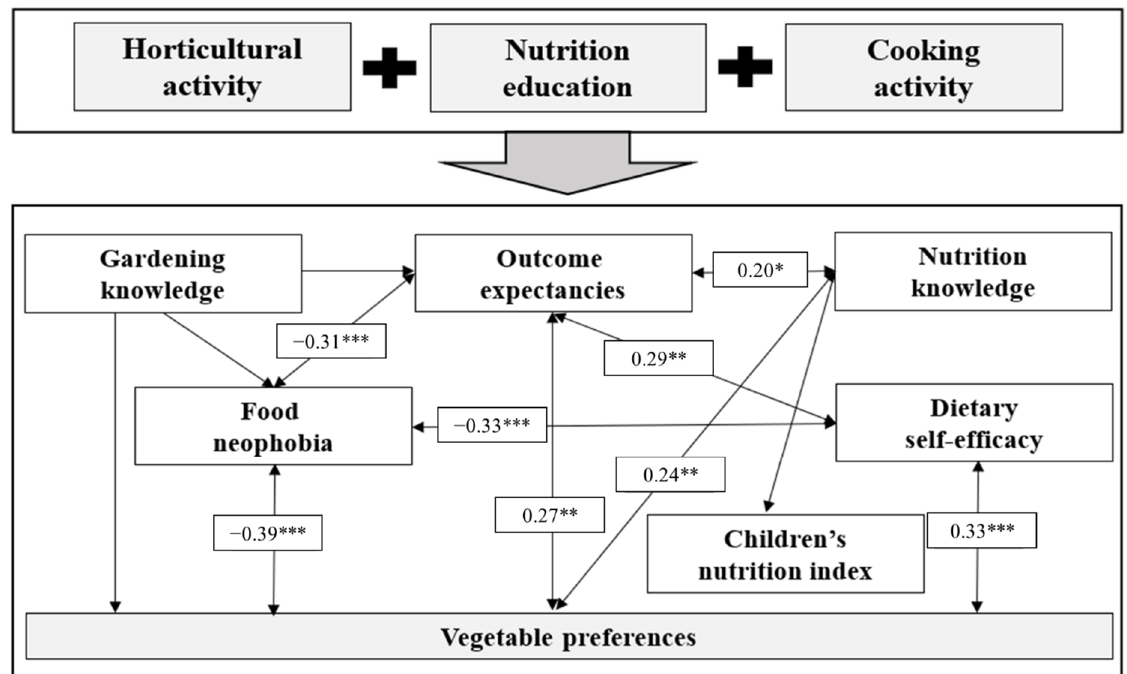
Figure 1. The result of the correlations between mediating factors for improving elementary school children’s vegetable preference ( N = 136). * p < 0.05, ** p < 0.01, *** p < 0.001. A correlation coefficient of less than ±0.2 means little correlation, that of ±0.2 to ±0.4 means low correlation, that of ±0.4 to ±0.7 means somewhat high correlation, and that of more than ±0.7 means high correlation [48].